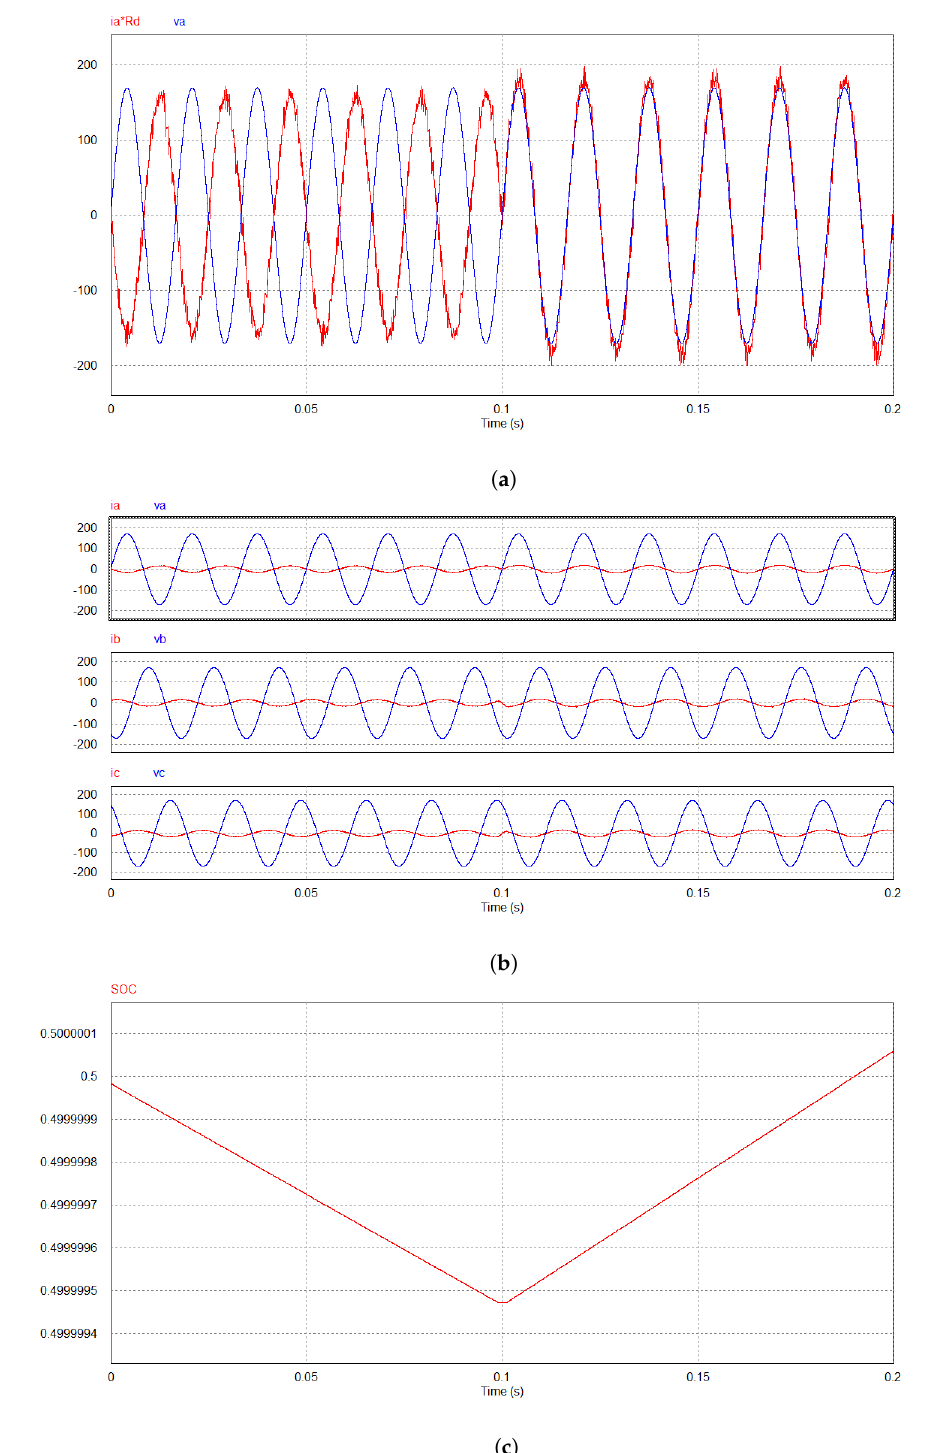
Figure 7. Simulation results for a sudden change in the mode of operation from discharging when R d = − 10 Ω to charging mode when R d = 10 Ω . ( a ) The voltage of Phase-a and its current multiplied by R d . ( b ) The input voltage and current of each phase. ( c ) The battery